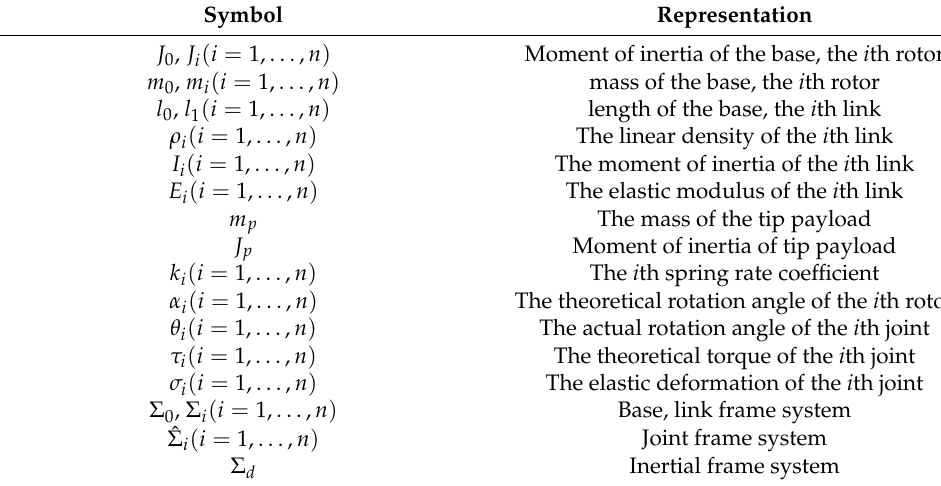
Figure 1. Schematic of a flexible manipulator system. Table 1. Kinematic and dynamic symbols of the space manipulator system.